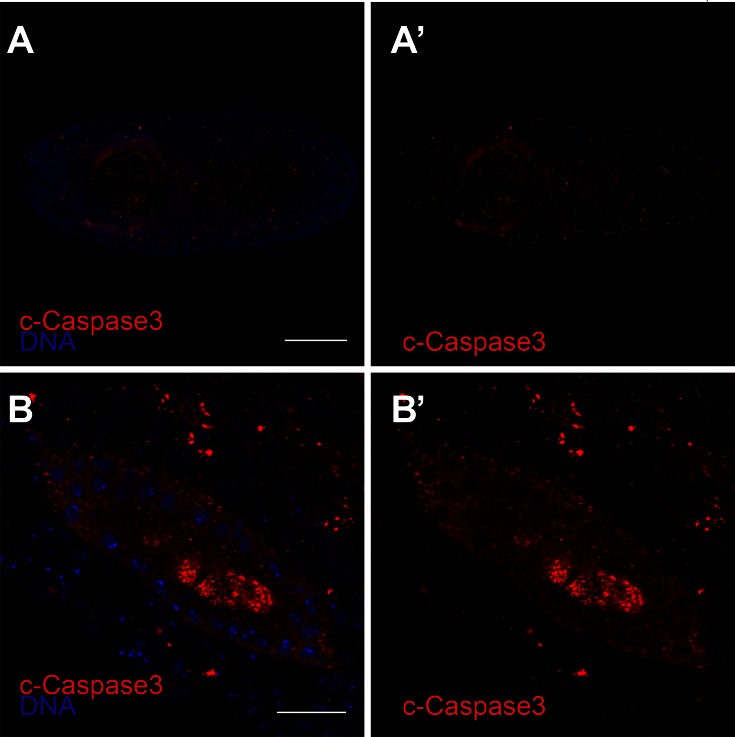
Anti-cleaved caspase-3 (red) and DAPI (blue) staining of stage 14 embryo (A) and high magnification of a salivary gland (B).(A'–B') are cleaved caspase-3 only. Scale bar in A is 20 μm, in B is 100 μm.